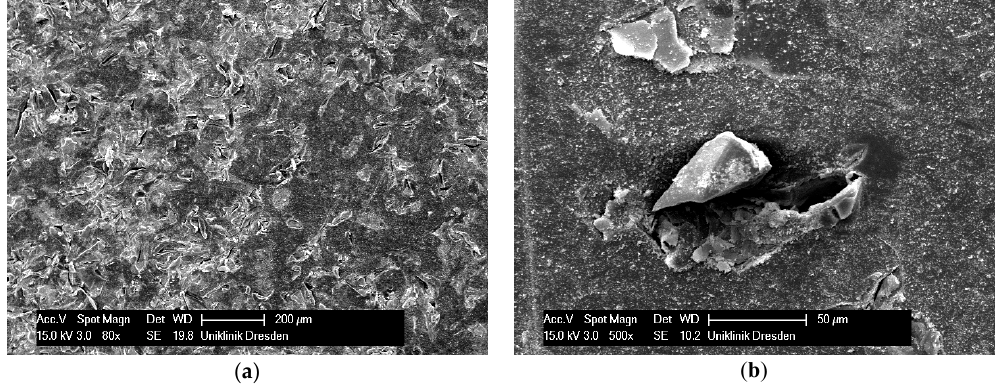
Figure 8. SEM picture of PMMA surface sandblasted at 2.8 bar Rocatec Pre and Rocatec Plus ( a ) magnification 80×; ( b ) single impacted particle, magnification 500×).